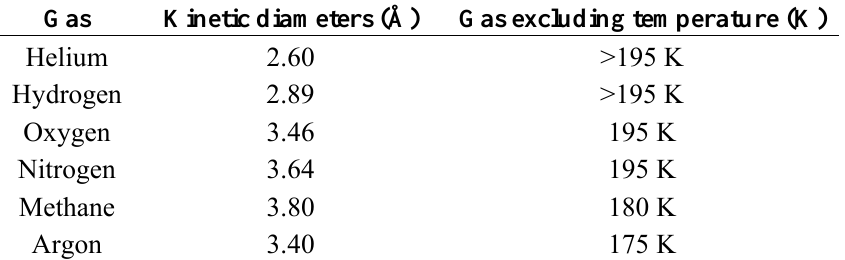
Table 1. Kinetic diameters and excluding temperatures of the gas